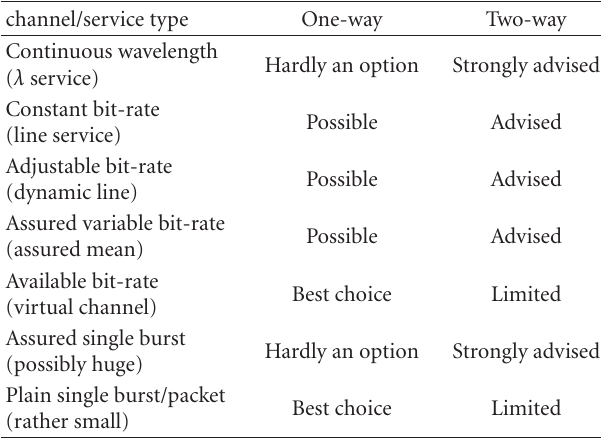
Table 2: FTM channel/service types and signaling